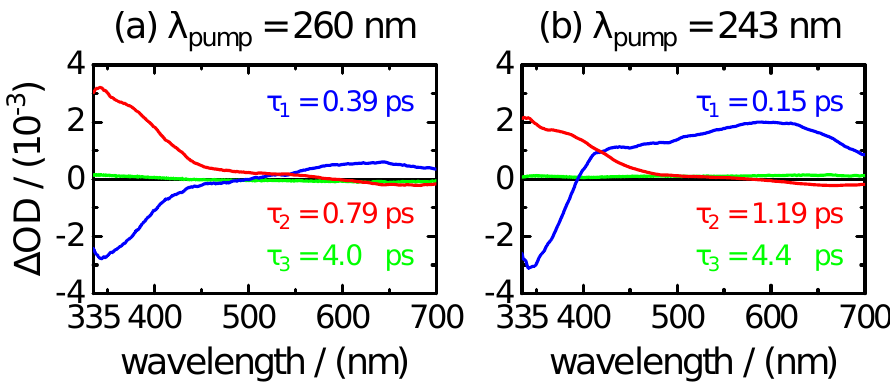
Figure 6. Decay time-associated difference spectra (DADS) vs. probe wavelength for XMP after excitation at ( a ) λ pump = 260 nm and ( b ) λ pump = 243 nm. τ 1 : blue; τ 2 : red; τ 3 : green. Table 2. Time constants describing the electronic deactivation of XMP after photoexcitation at λ pump = 260 and 243 nm provided by the global SVD analyses ( (cid:104) av. (cid:105) indicates the averaged values). λ pump /nm τ 1 /ps τ 2 /ps τ 3 /ps 260 0.39 ± 0.10 0.79 ± 0.13 4.0 ± 1.0 243 0.15 ± 0.03 1.19 ± 0.08 4.4 ± 1.0 (cid:104) av. (cid:105) 0.27 ± 0.15 1.00 ± 0.20 4.2 ±